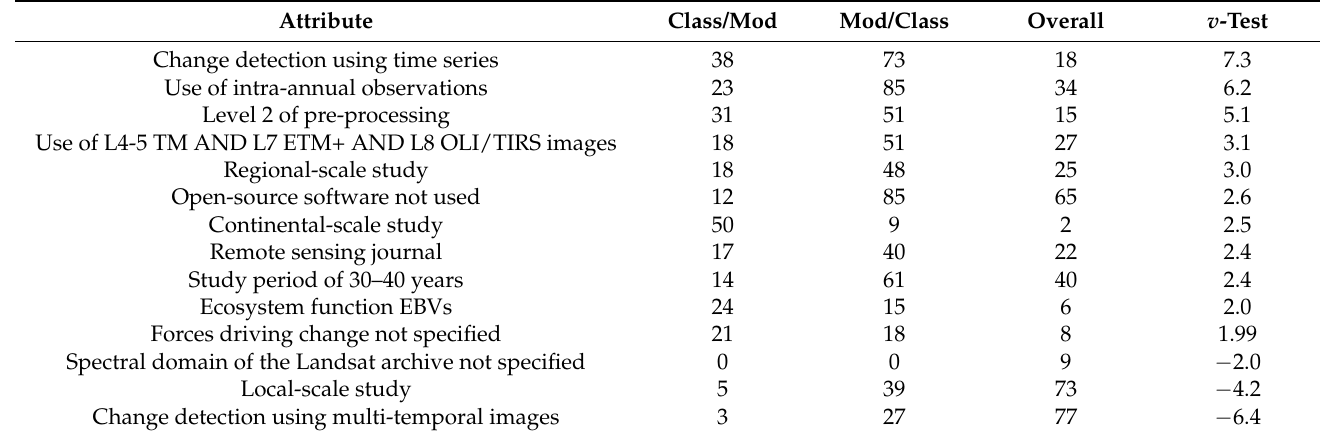
Table 2. Frequency (percentages) of attributes in studies that used Google Earth Engine that differed significantly (| v -test| > 1.96) from the frequency in all studies reviewed. “Class”: Studies that used Google Earth Engine; “Class/Mod”: studies with the attribute and belonging to the class; “Mod/Class”: studies belonging to the class and with the attribute; “Overall”: frequency of the attribute in all studies, regardless of the class; EBVs: essential biodiversity